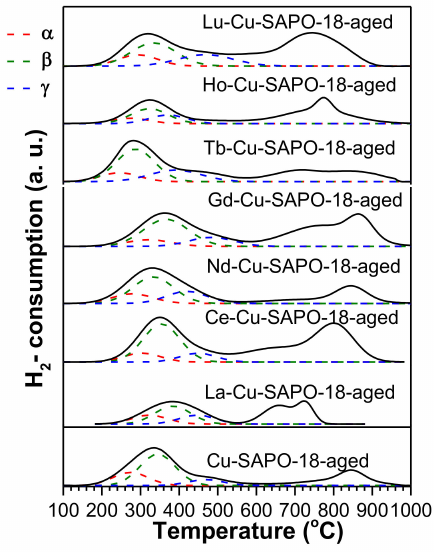
Figure 9. H 2 -TPR profiles of the aged